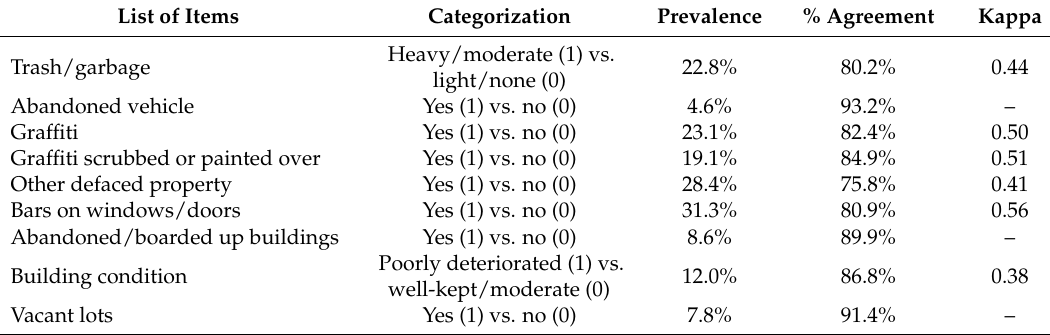
Table 1. Neighborhood Physical Disorder Items and Inter-Rater Reliability for Block Faces Audited using Google Street View 1,2